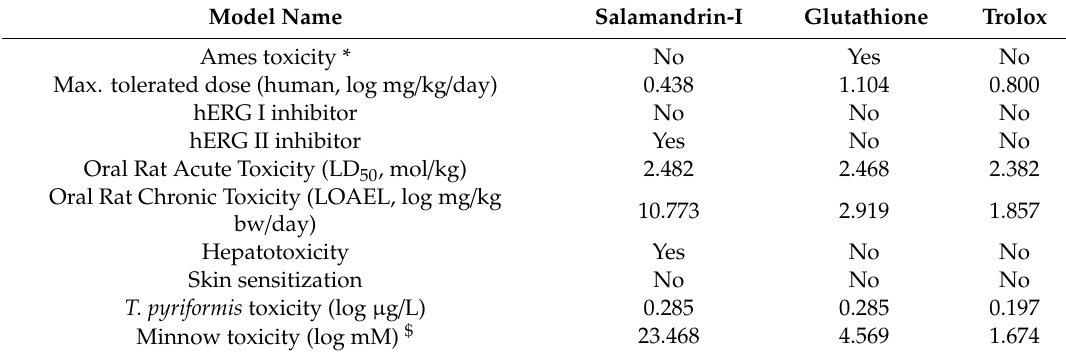
Table 3. In silico toxicology. Computer-aided toxicity parameters and recommended ranges of oral administration of active